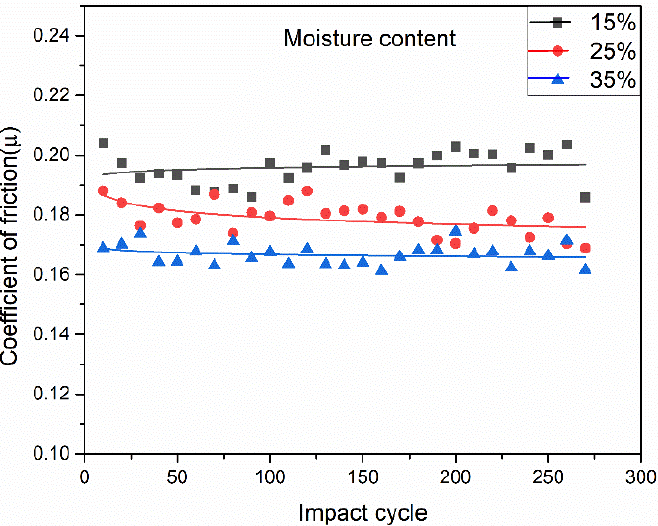
Figure 9. Change in the coefficient of friction depending on the different moisture content condi- tions.